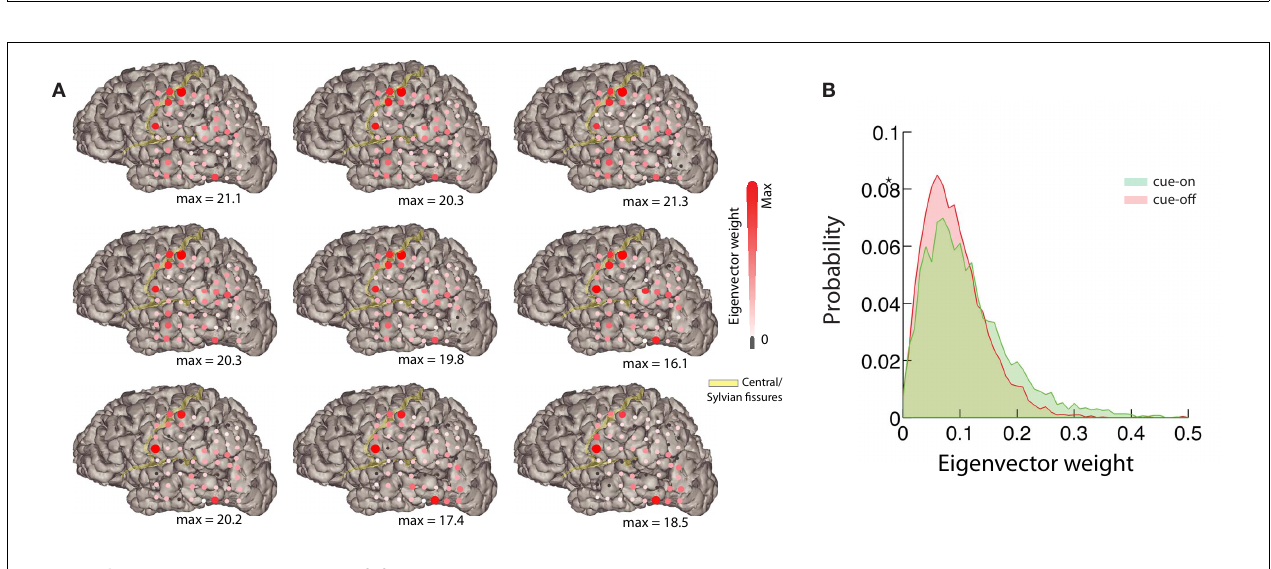
FIGURE 6 | Mapping of the eigenvectors. (A) Relative difference between the mean eigenvector of cue-on and cue-off periods corresponding to the 9 most unstable modes for one subject (top left: most unstable; decreasing order from left to right, top to bottom). Each red circle corresponds to a component of the eigenvector. Its size and color represents the magnitude of